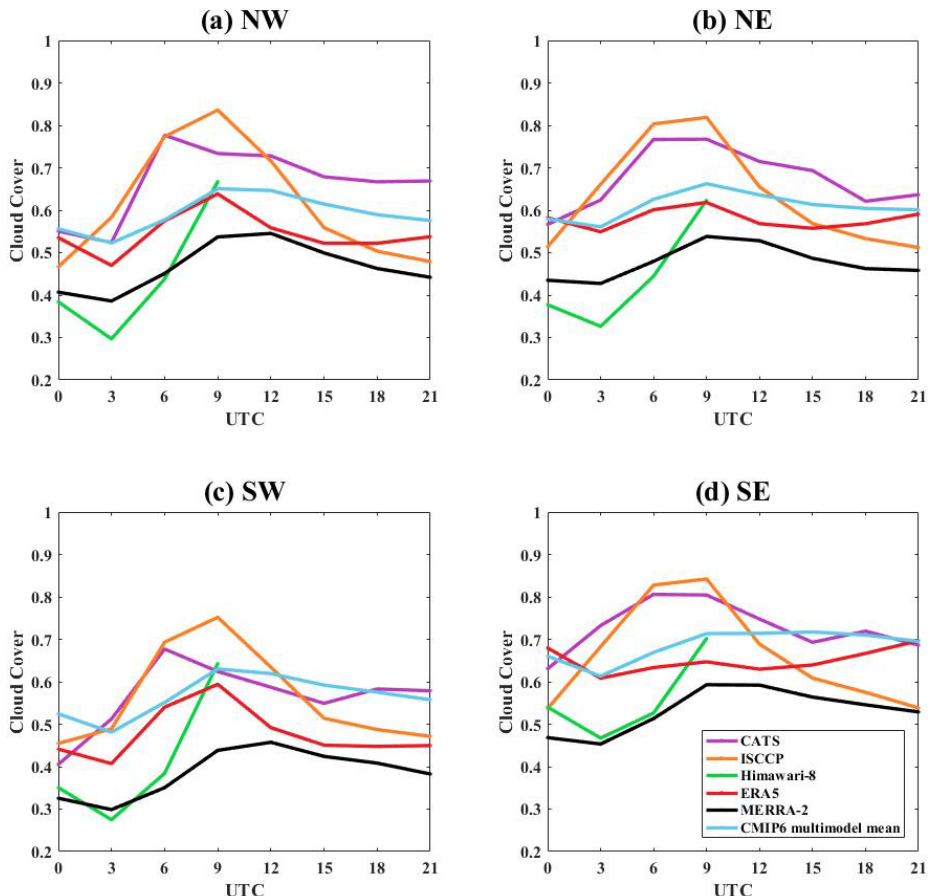
Figure 2. The 3-hourly mean total cloud cover in different regions of the TP based on CATS (purple lines), ISCCP-H (orange lines), Himawari-8 (green lines), ERA5 (red lines), MERRA-2 (black lines), and CMIP6 multimodel mean (blue lines). (a) The northwestern TP, (b) the northeastern TP, (c) the southwestern TP, and (d) the southeastern TP. The regions are divided by latitude and longitude lines of 33 ◦ N and 89 ◦ E and the boundary of the TP (shown in Fig.